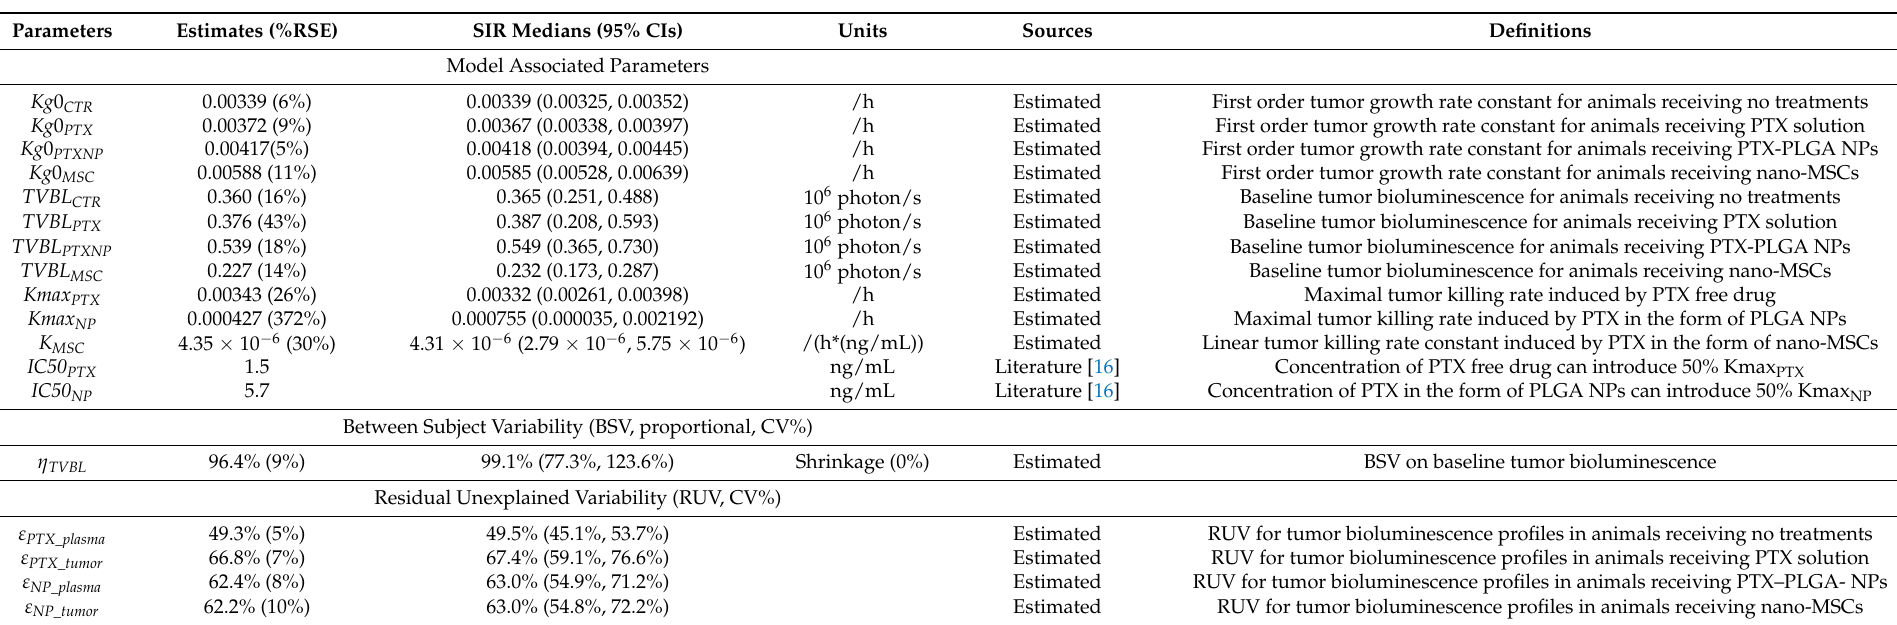
Table 2. Parameters for pharmacodynamic